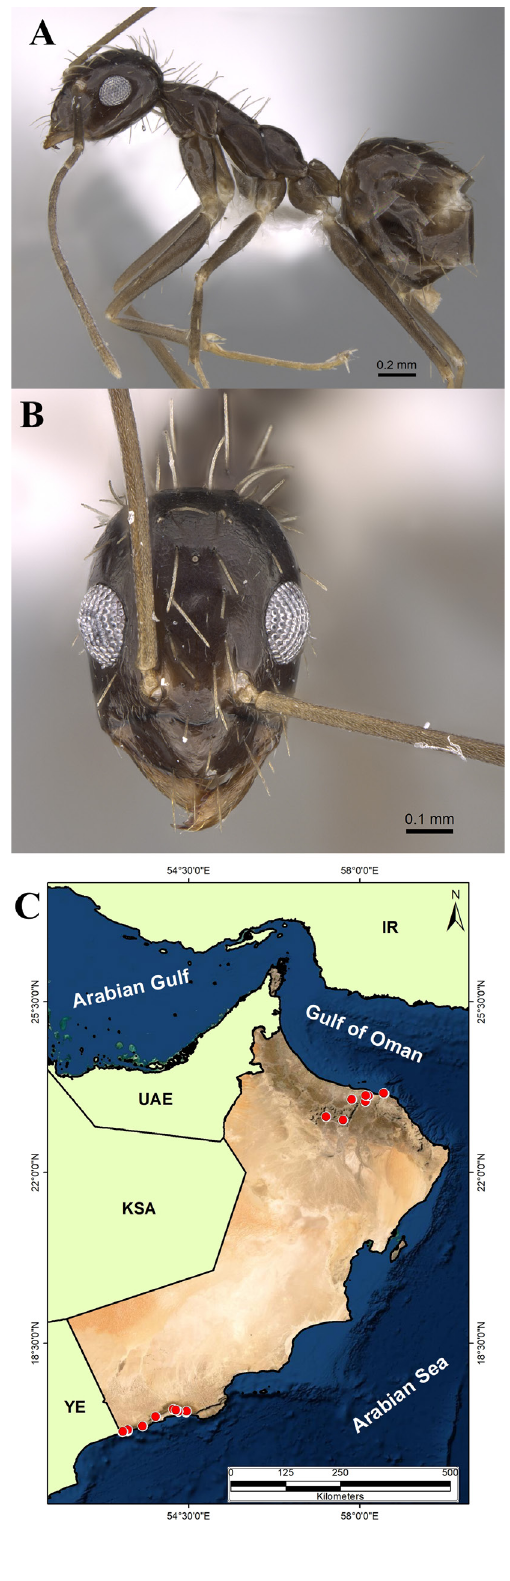
Fig. 23. Paratrechina longicornis (Latreille, 1802), worker (CASENT0922867, AntWeb.org (Michele Esposito)). A . Body in profile. B . Head in full-face view. C . Distribution